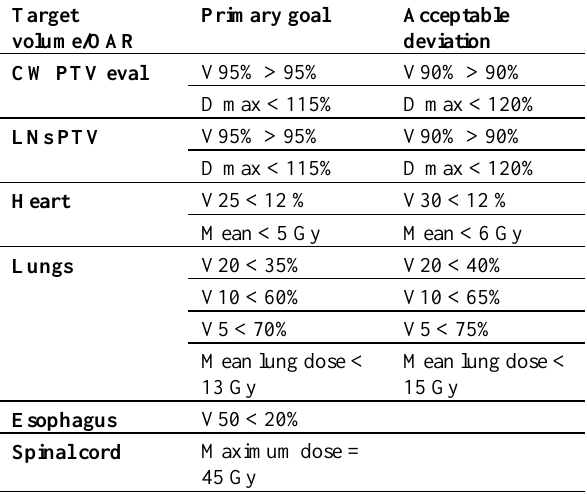
Table 1: Dose constraints for both PTV coverage and dose to organs at